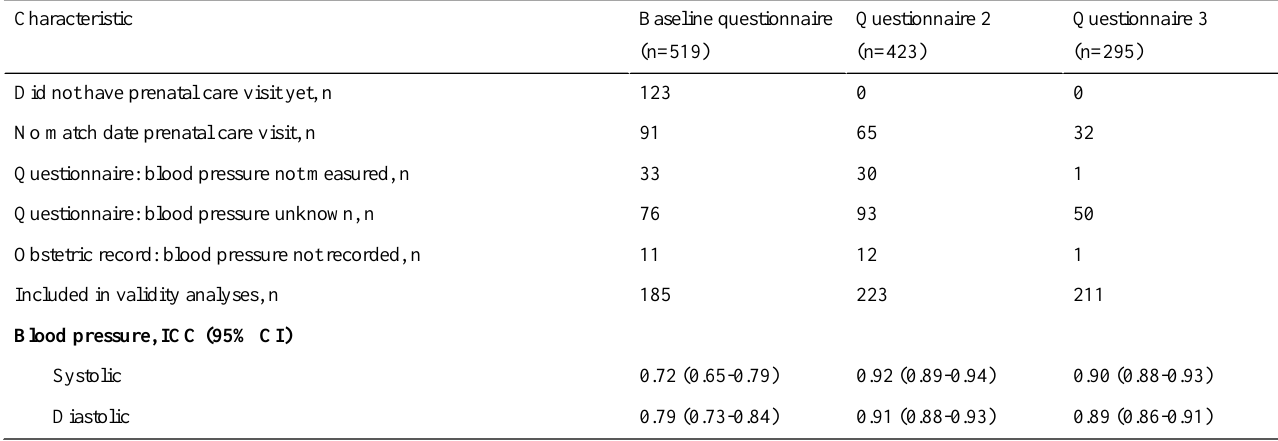
Table 5. Validity analyses comparing Web-based questionnaires and obstetric records for systolic and diastolic blood pressure readings: sample description and intraclass correlation